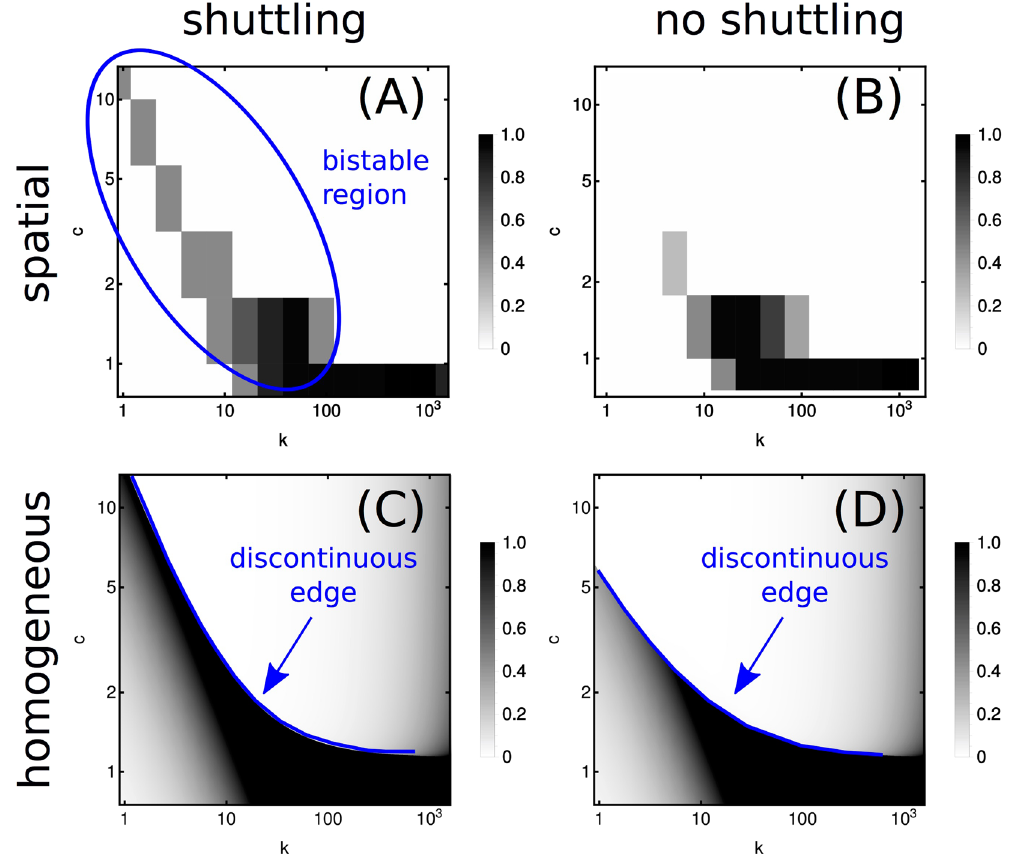
Figure 7. Effect of shuttling in spatial and homogeneous model. Phase portraits obtained for the spatial ( A , B ) and the homogeneous ( C , D ) models, with enabled ( A , C ) and disabled ( B , D ) overflow product shuttling. Notice that the range of values of c and k are narrower with respect to those employed in Figs 3 and 4A. Outside the shown ranges, turning off re-cycling by healthy cells appears to bear no impact on the final state of the tissue. Notice that aberrant growth in the region of bistability shown in ( A ) is significantly reduced by silencing the shuttle, see ( B